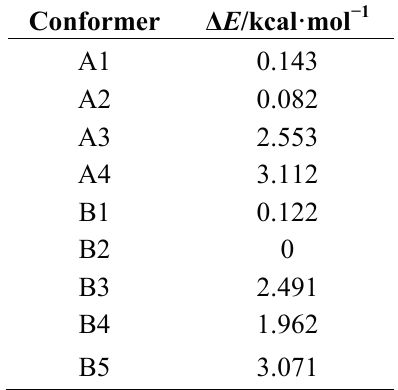
Table 3. Single point calculations at the MP2/6-31G(d,p)//B3LYP/6-31G(d,p)